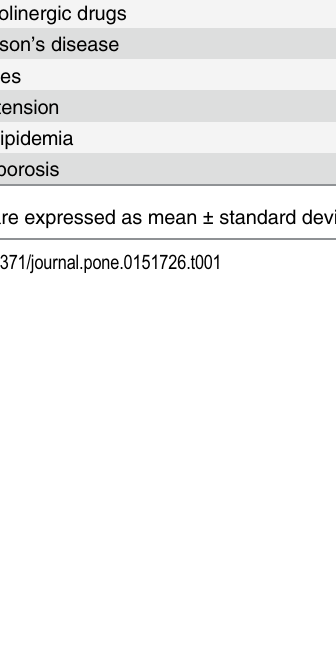
Table 1. Baseline characteristics.